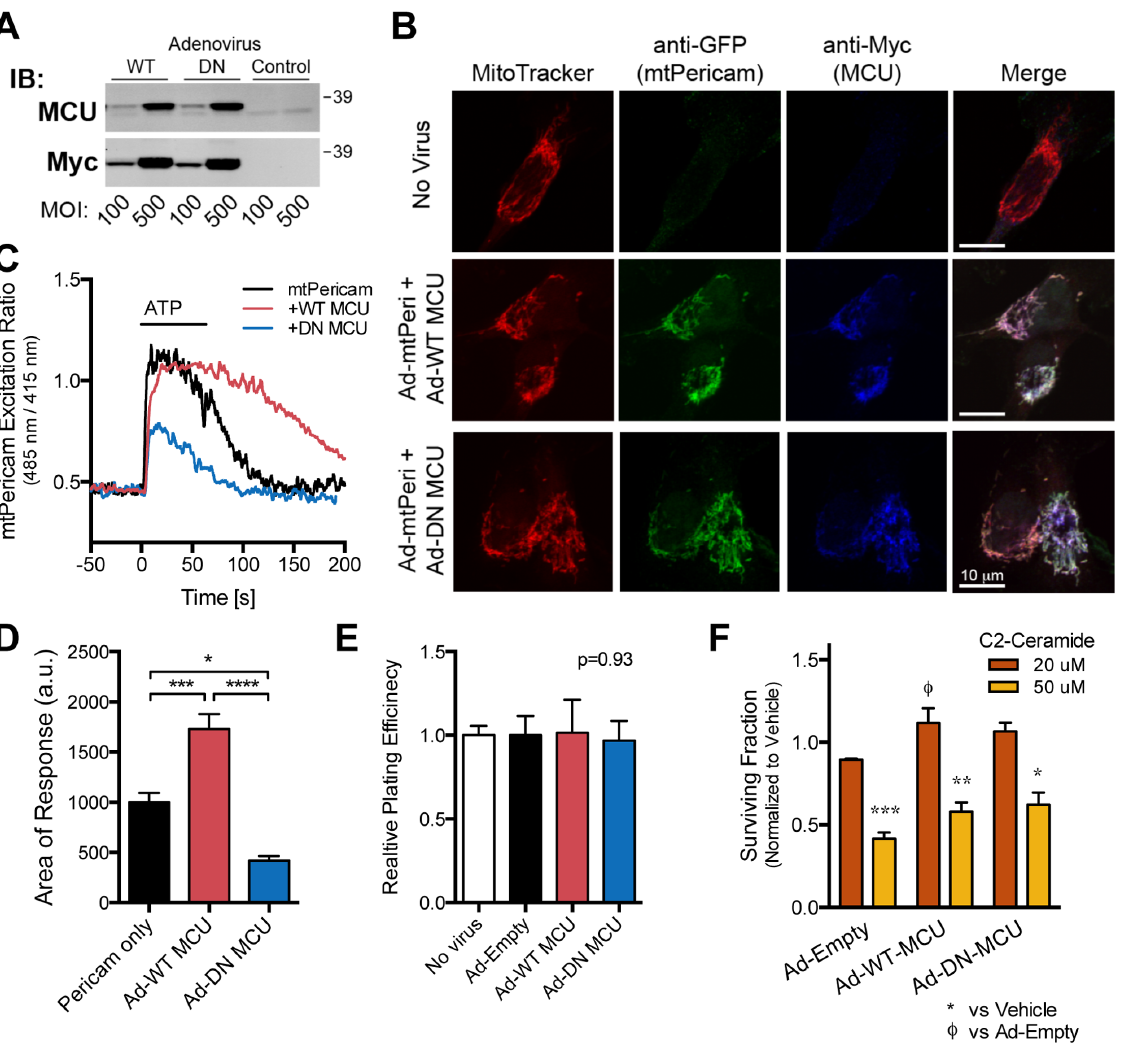
Figure 5. Overexpression of WT or DN MCU does not alter MDA-MB-231 cell survival. A, B. Adenoviruses engineered to overexpress MCU express full length, mitochondrial localized MCU. A. Immunoblot (IB) of MDA-MB-231 cell lysates infected with MCU-expressing adenoviruses at indicated MOI for total MCU (top) and C-terminal Myc-tag (bottom). Endogenous MCU expression can be seen as a slightly faster migrating band than tagged MCU as detected by the total anti-MCU antibody and present in control infected samples. B. Representative confocal immunofluorescent micorgraphs of cells with and without co-infection of MCU and mt-Pericam viruses. Mitochondrial were labeled with MitoTracker (red), fixed, and immunostained with anti-myc (blue) for overexpressed MCU-myc and anti-GFP (green) for mt-Pericam fluorescence. Colocalization of mitochondria, mt-Pericam, and overexpressed MCU is evidenced by white pixels in the merged panels. Scale bar, 10 m m. C. Representative mt-Pericam signal (485 nm/415 nm excitation ratio) after stimulation with 100 m M ATP as indicated with and without co-infections of MCU expressing viruses. D. Summary data for the integrated area of mt-Pericam responses (n=30–86). E. Plating efficiency of MDA-MB-231 cells after infection with indicated adenoviruses by clonogenic assay (n=3–9). F. Results of clonogenic survival assays of adenovirally transduced cells after 24 hour treatment with C2- ceramide (n=3–9).